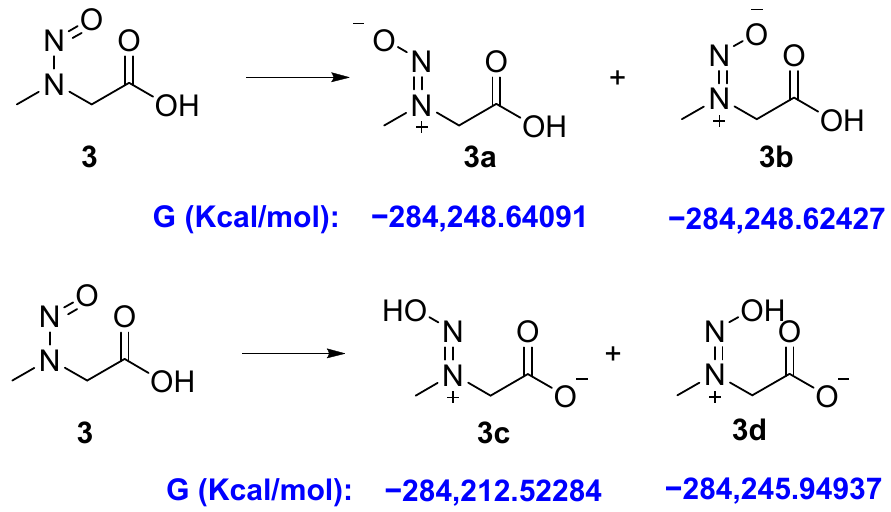
Figure 3. The Gibbs free energies and energy difference of the four possible conformers 3a – 3d . Compounds 4 and 7 have sp 2 CH or CH 2 , which could affect the stability of the isomers. For compound 4 , we considered four possible stable conformers, and their energies were calculated. As shown in Figure 4, the interaction of N=O and sp 2 CH can be represented through the energy difference between E 1 and E 2 . Similarly, the interaction between N=O and sp 2 CH 2 can be shown through the energy difference of E 4 –E 1 . In addition, the interaction between the nitrogen atoms of N=O and sp 2 CH 2 can be interpreted by the energy calculation of E 3 and E 1 . On the basis of their energy differences, the closer sp 2 values of CH or CH 2 and N=O are, the more unstable they are. Thus, for compound 7 , the pyridine ring is rich in electrons, similar to the double bond in compound 4 , which repels the N=O-containing electrons. Meanwhile, considering the steric hindrance of pyridine, the E -configuration of 7 is more stable than the Z -configuration, which is consistent with the energy calculation.